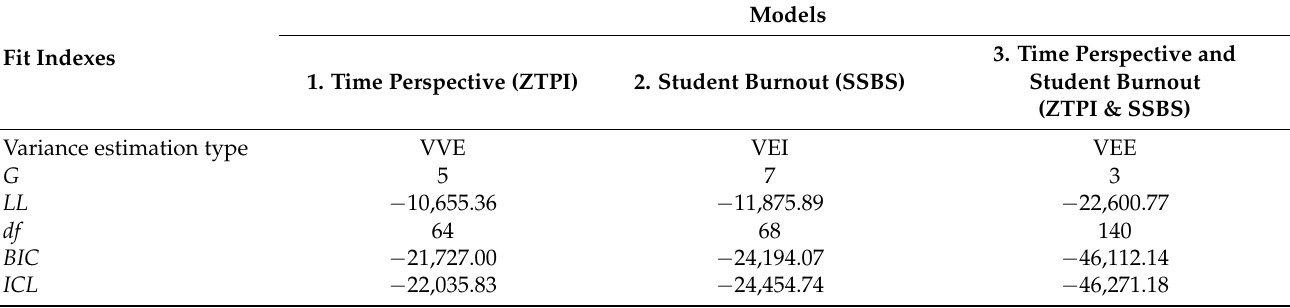
Table 1. Fit indices of latent profile models of time perspective (ZTPI scale) and school burnout (SSBS scale) profiles ( N =